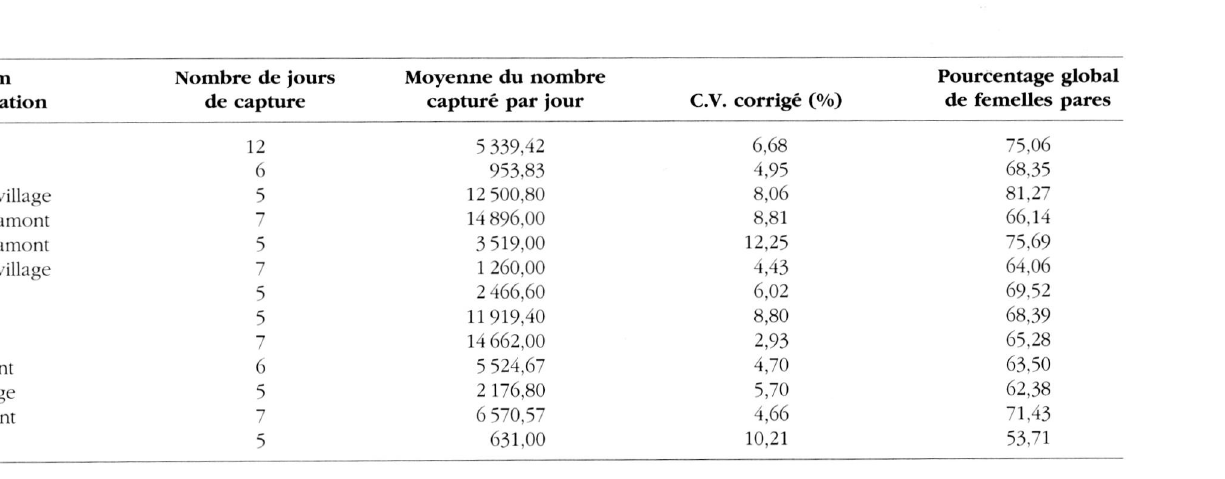
Tableau II. - Résultats globaux obtenus pour chaque station de capture à Nuku-Hiva en 1972. Le coefficient de variation corrigé pour les petits effectifs (C.V. corrigé) est un indice de dispersion relative calculé : C.V. corrigé = [1 + (1/4 effectif))* C.V.], avec C.V. = 100* écart- type/moyenne (Scherrer,